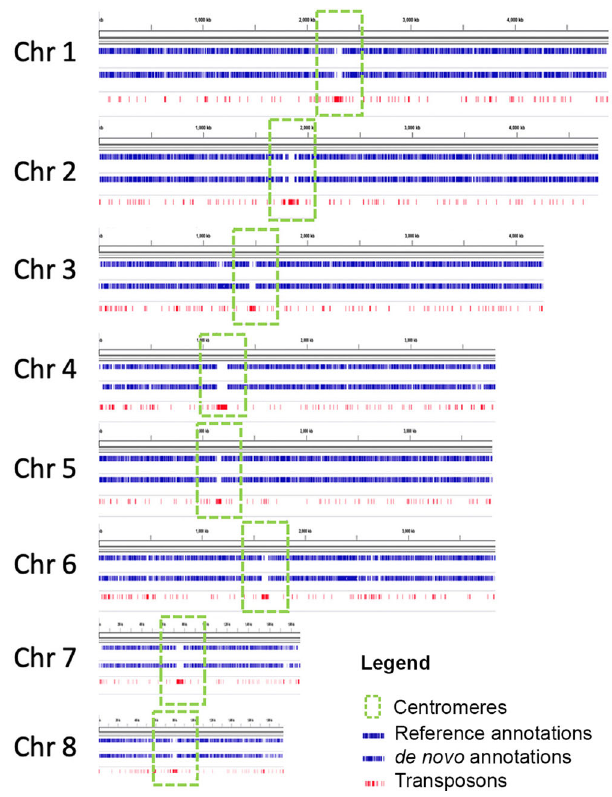
Fig. 2 | Annotation of A1160 genome assembled in eight chromosomes. Gen- omes are annotated in a cursory manner using Exonerate mapping of transcripts andproteinsfromFungiDBanddenovogenepredictionusingGenemarkEP+and Braker1 and Braker2. Transposons are mapped using Exonerate (Transposons). Genes are shown as blue bars and transposons are shown as red bars. Putative centromeres,enrichedwithtransposons,areindicatedbygreenrectangularboxes. Random PCR RNAseq data from NCBI was merged and mapped to genomes using HiSat2. Chr –